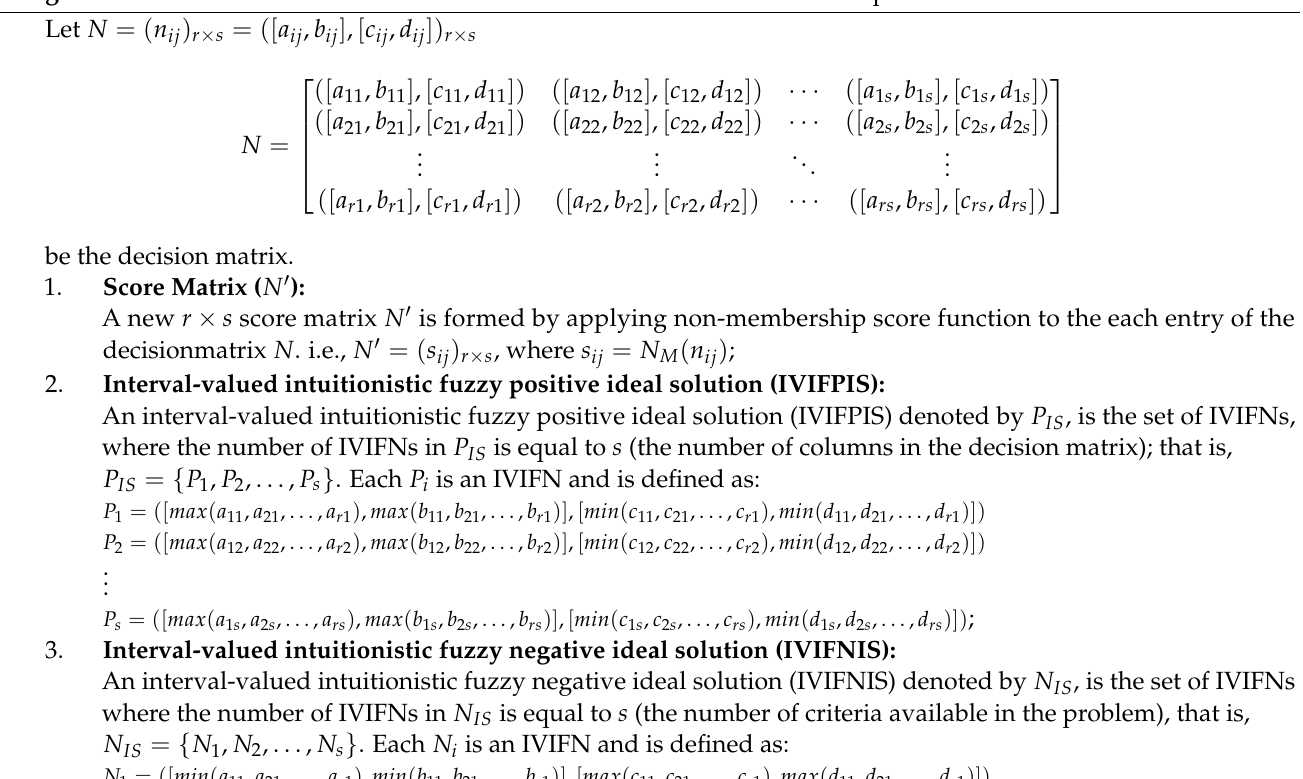
Algorithm 1: IVIF-MCDM method based on IVIF-TOPSIS and nonmembership score